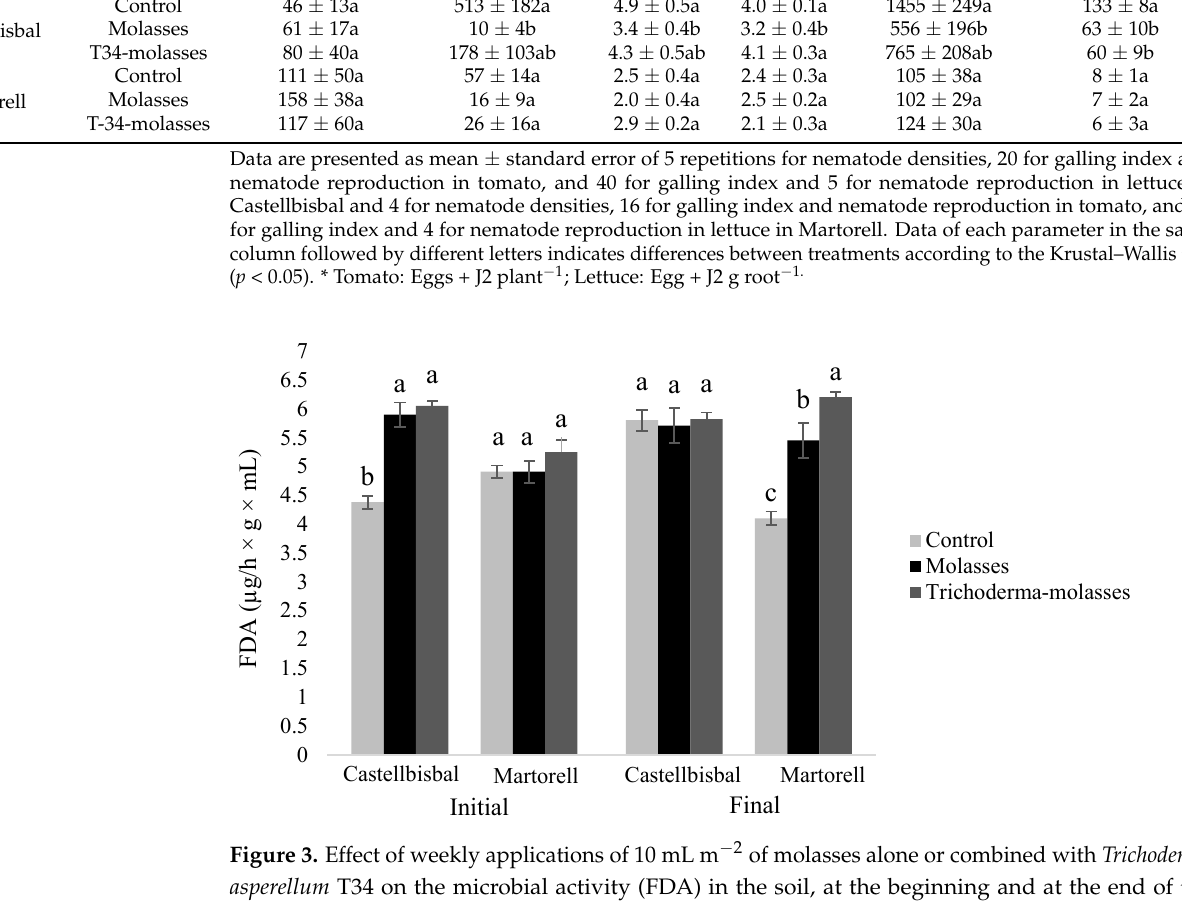
Table 5. Effect of weekly applications of 10 mL m −2 of molasses alone or combined with Trichoderma asperellum T34 on the nematode densities in soil (Pi; Pf) and in roots (nematode reproduction) and the disease severity (galling index) in the intercropped tomato cv. Bodar at the end of the first nem- atode generation and the lettuce cv. Paraday at the end of the crop in two organic vegetable produc- tion sites.